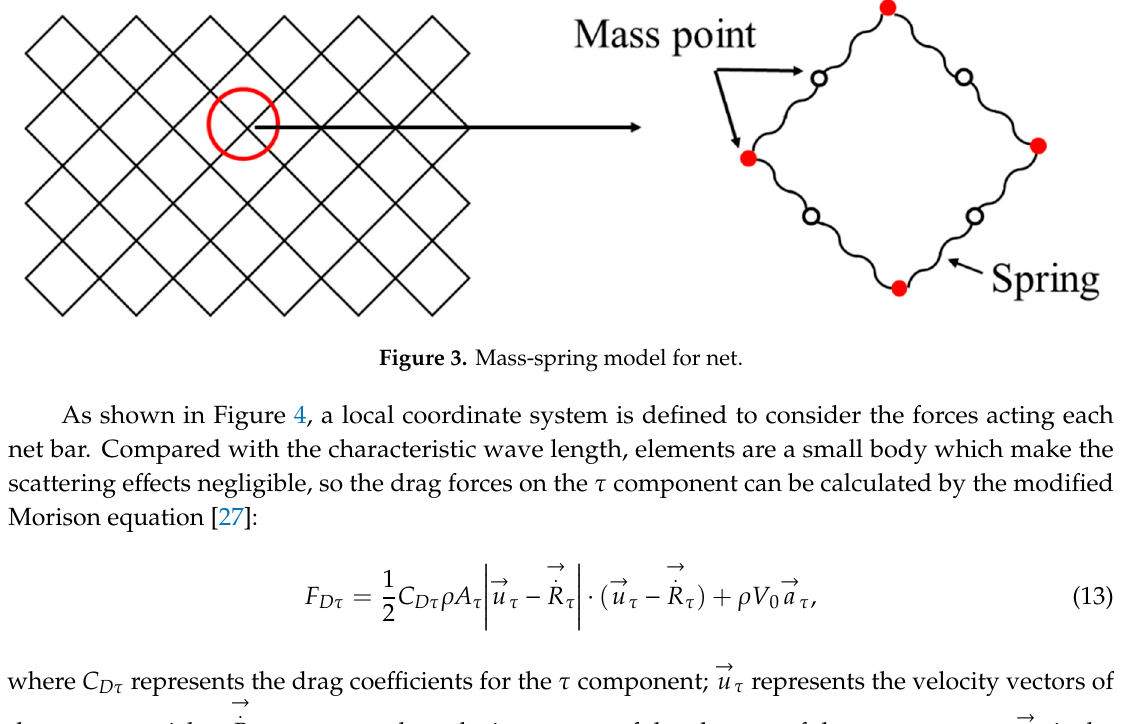
Figure 4. Local coordinate system for a net element.